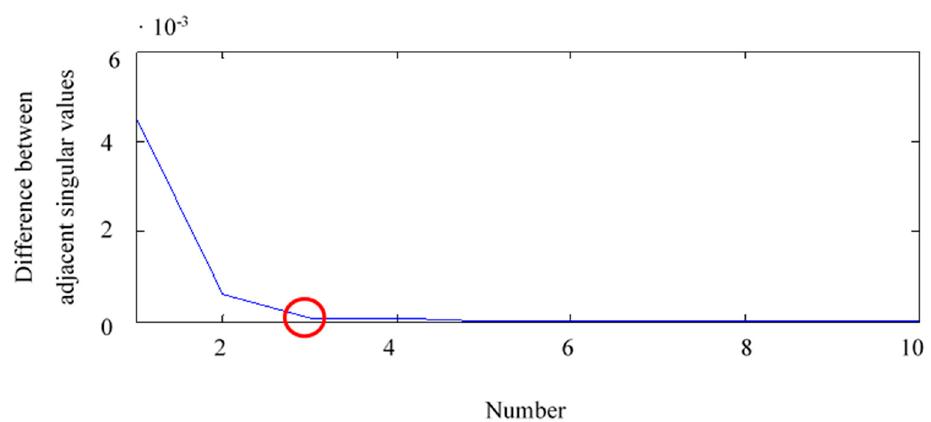
Figure 16. A line graph of adjacent singular value differences obtained by the empirical mode decomposition-singular value decomposition (EMD-SVD) method.